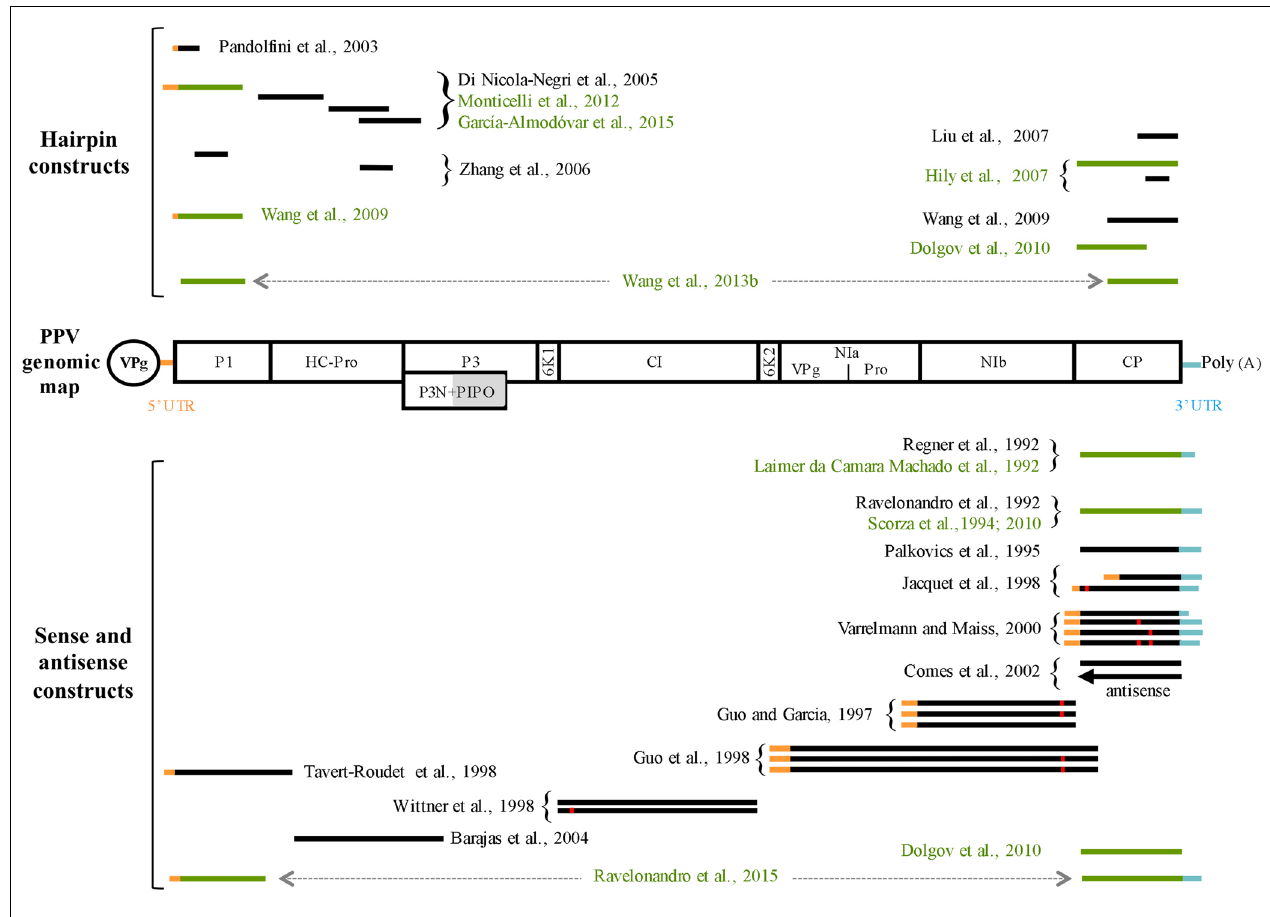
FIGURE 1 | Genomic map of Plum pox virus (PPV) and schematic representation of PPV sequences utilized for obtaining transgenic PPV-resistant plants. The long viral open reading frame is represented by a box divided into different proteins, named accordingly. PIPO protein, which is expressed after a frameshift, is indicated by a grey box below the P3 region. The viral protein linked to the genome (VPg) is represented as an ellipse. PPV sequences utilized for obtaining transgenic plants are schematized as horizontal lines above (hairpin constructs) or below (sense